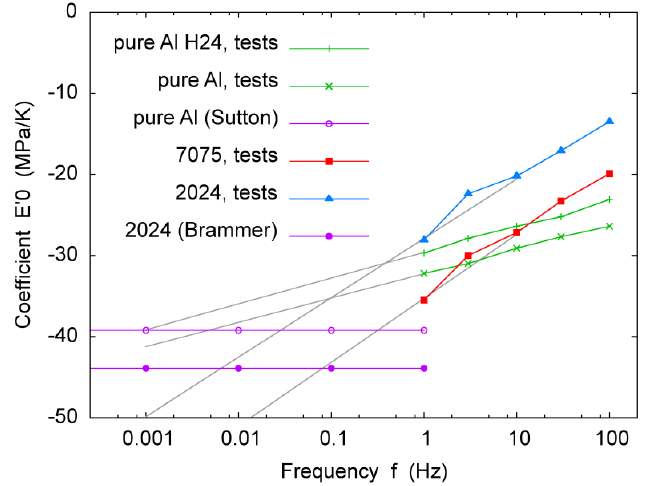
Figure 3. Temperature softening coefficient E 0 ’ vs. frequency f for pure Al in the H24 temper, pure Al, Al alloy (AA) 7075-T6 and AA 2024-T3, as obtained from linear regression of test data from the dynamic-mechanical analyzer. Logarithmic tendency lines fitted to the data to extrapolate them to lower frequencies are also shown, as well as the rates of loss of static elastic modulus with temperature, as obtained by linear regression of data in the literature for pure Al [36] and AA 2024 [35].